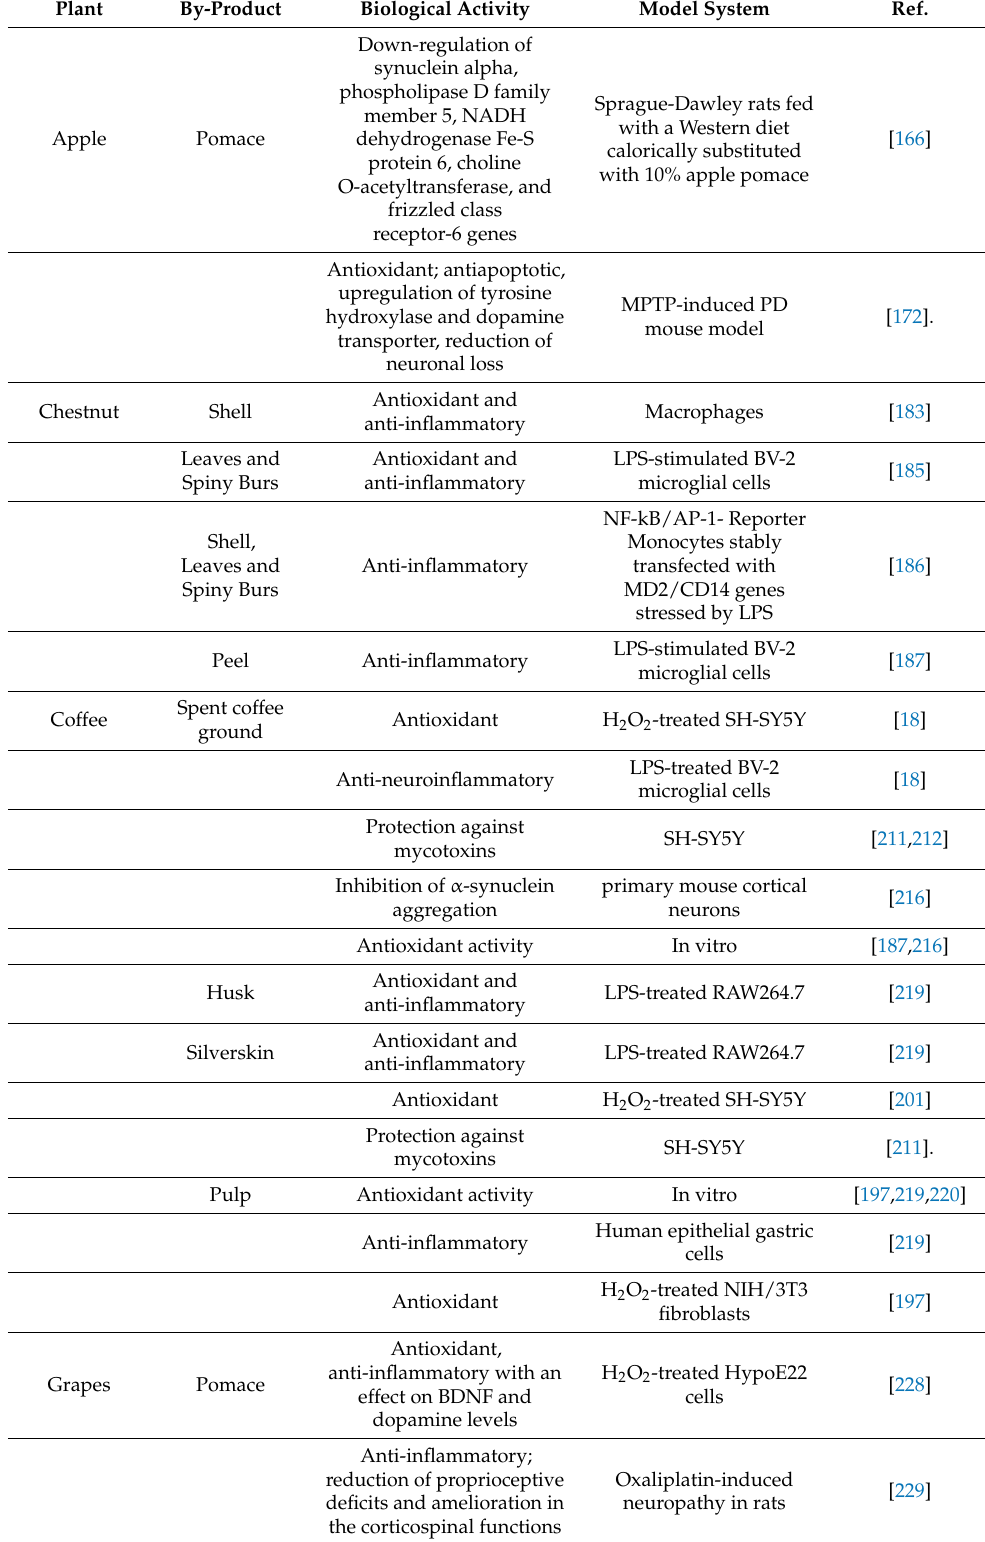
Table 1. List of the biological effects of the different